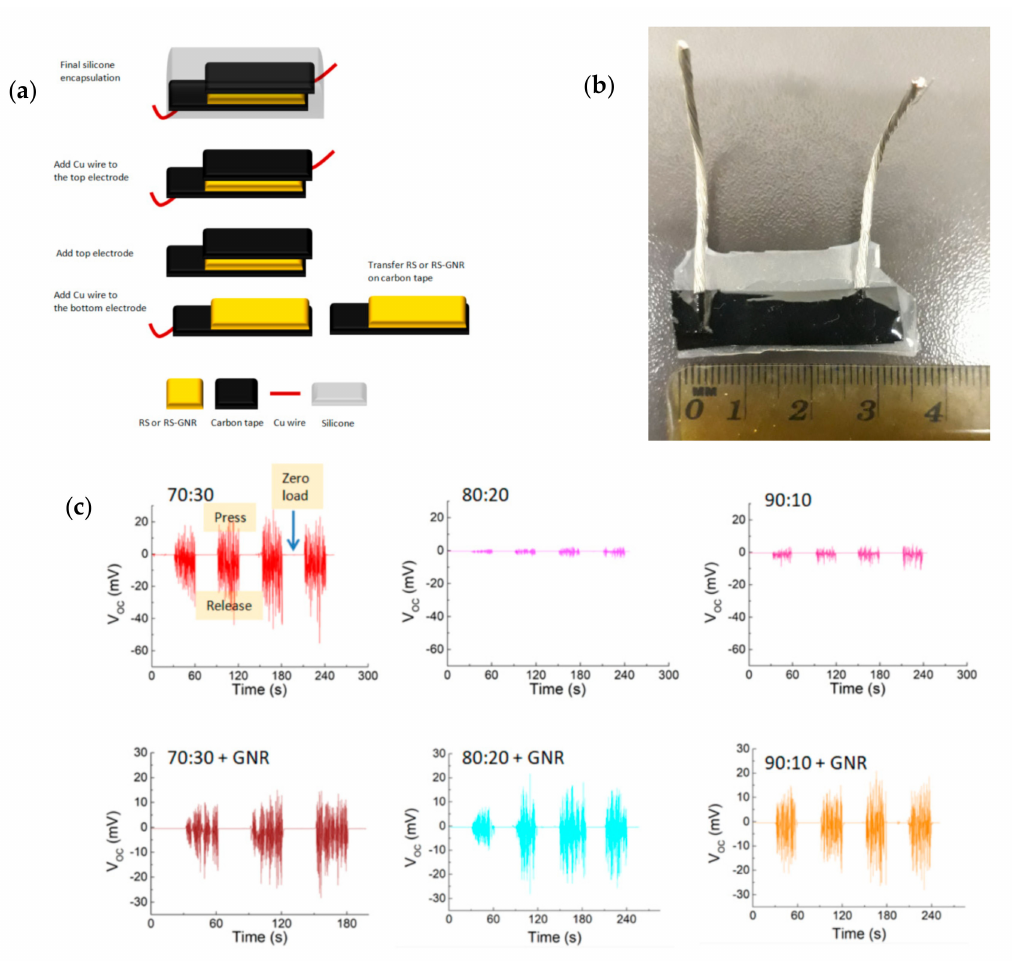
Figure 5. ( a ) Schematic of fabrication of piezoelectric device. ( b ) Photograph of piezoelectric device fabricated. ( c ) The generated output voltage of piezoelectric devices fabricated with di ff erent RS and RS-GNR films and subjected to repetitive loading and releasing